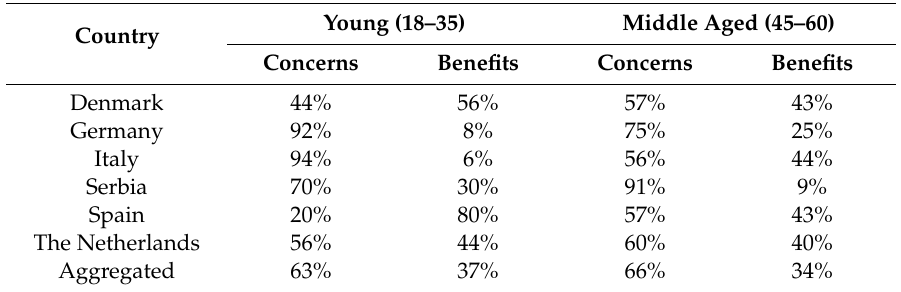
Table 3. Relative frequency (%) of concerns and expected benefits stated by young (18–35) and middle-aged (45–60) participants in all countries.